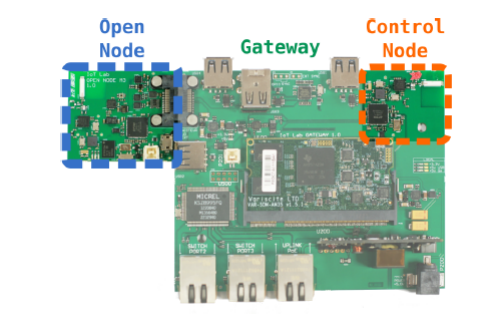
Figure 6. Hardware of an IoT-LAB node